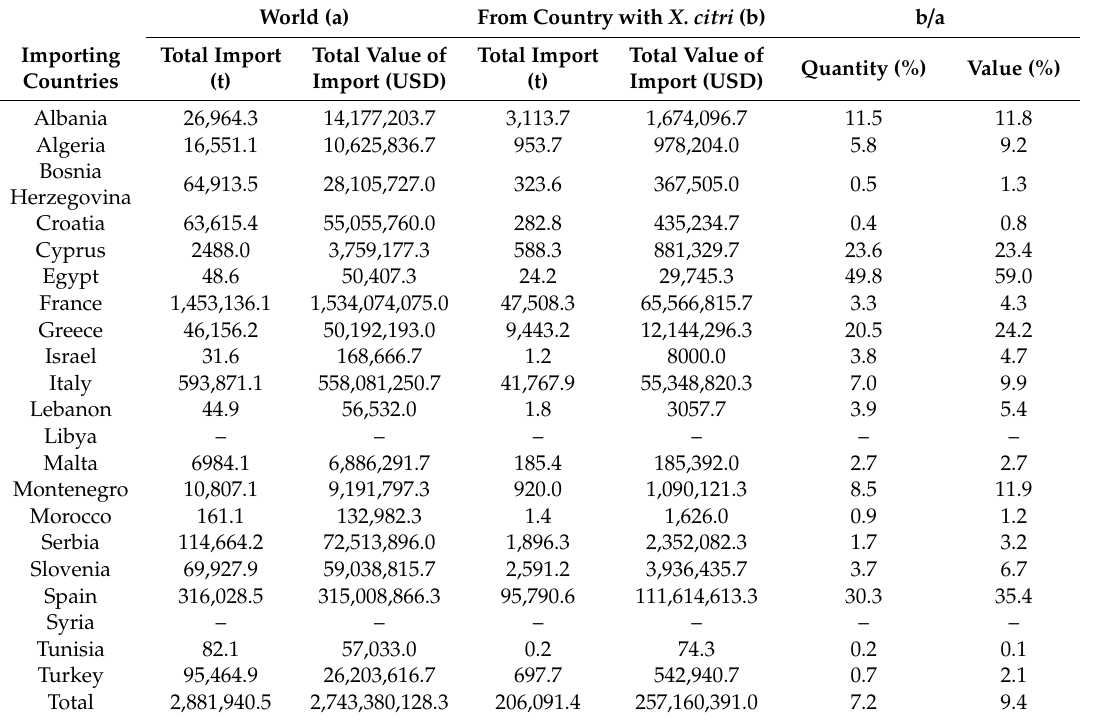
Table 3. Import of citrus fruit in the Mediterranean Basin (2015–2018)